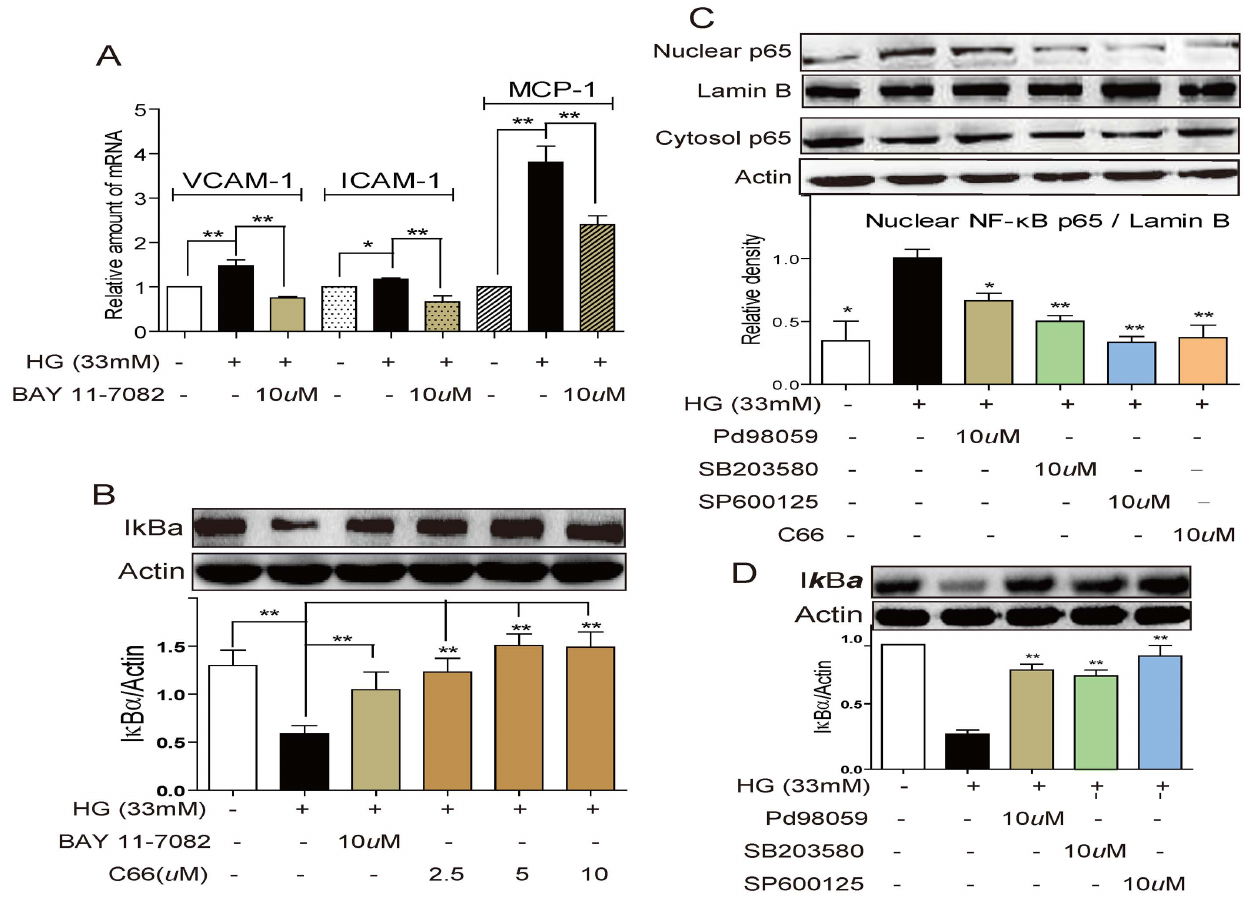
Figure 2. The inhibitory activity of C66 against expression of adhesion molecules is mediated by MAPK and NF- k B inactivation. A). NF- k B inhibitor reduced the mRNA expression of adhesion molecules and chemokines. B). C66 reversed HG-induced I k B a degradation in NRK-52E cells. C) Western blot analysis of nuclear and cytosolic protein (normalized optical density as percentage of low glucose-treated group) showed both C66 and specific inhibitors of MAPKs inhibited HG-induced NF- k B p65 nuclear translocation. D) MAPK inhibitors down-regulated the HG-induced NF- k B activation. RNA levels are expressed as a ratio of b -actin, normalized to controls. Actin was used as a loading control. Bars represent the mean 6 SD of more than three independent experiments (* p , 0.05, ** p , 0.01, *** p , 0.001).